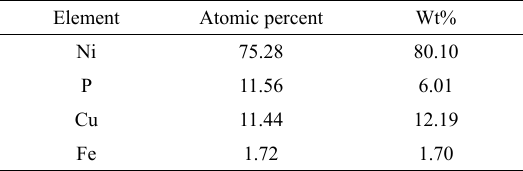
Table 7. The amount of different alloying element in Ni-P- 5gr/lit Cu composite coating. Element